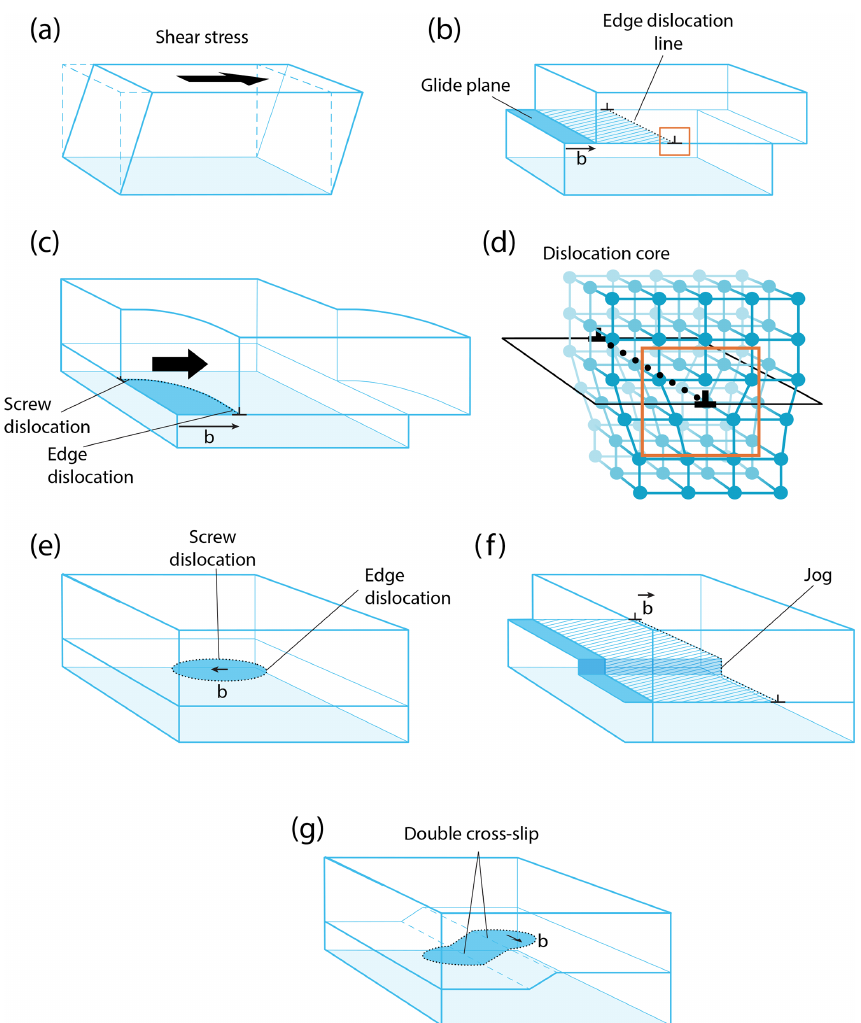
Figure 6. Dislocations in crystalline solids: (a) deformation by shear stress; (b) translation by edge dislocation, showing the glide plane, the dislocation direction, and the Burgers vector b ; (c) a screw and edge dislocation; (d) the core of an edge dislocation, corresponding to the orange square in (b) ; (e) a dislocation loop; (f) dislocation climb by activity on a jog; and (g) dislocation cross